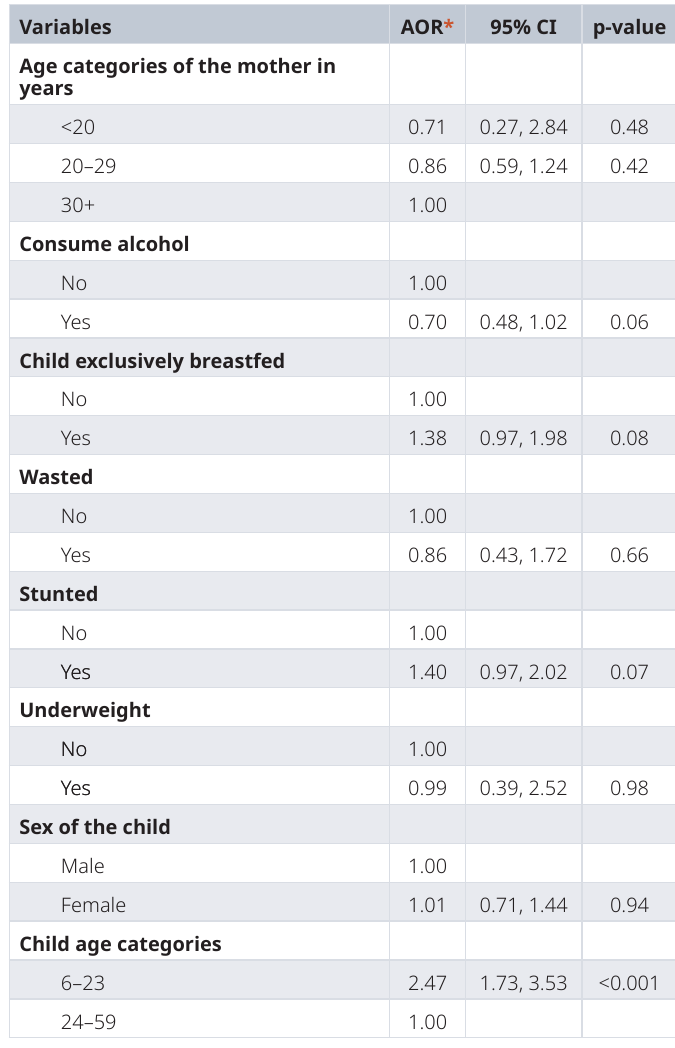
Table 4. Adjusted analysis for factors associated with anemia in children under five